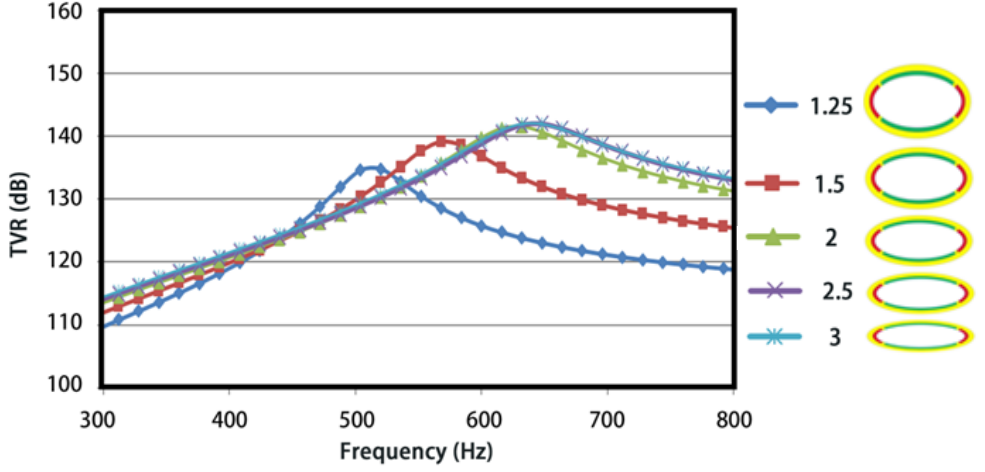
Figure 10. Influence of the ratio of major-minor axis on the TVR.